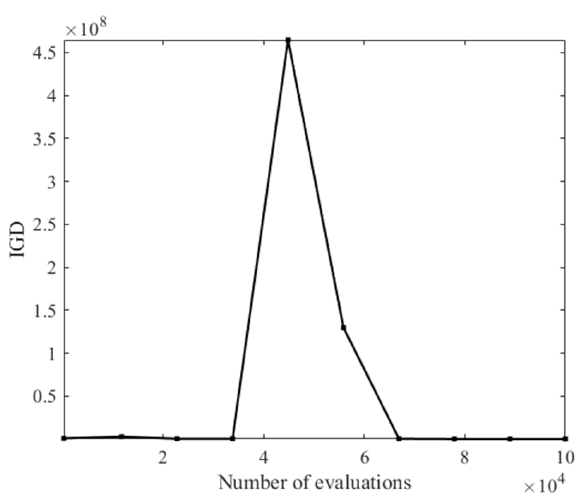
Figure 4. Change of IGD value with the number of assessments (10 objective).